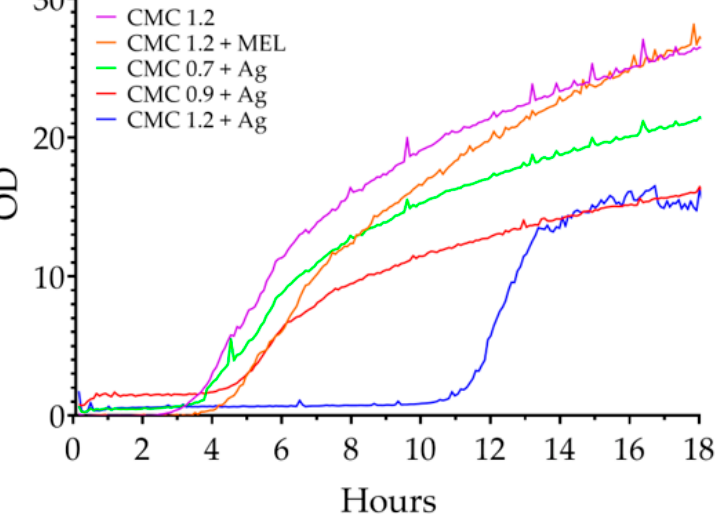
Figure 10. Changes in the optical density of liquid C. albicans cultures in the presence of the films tested.